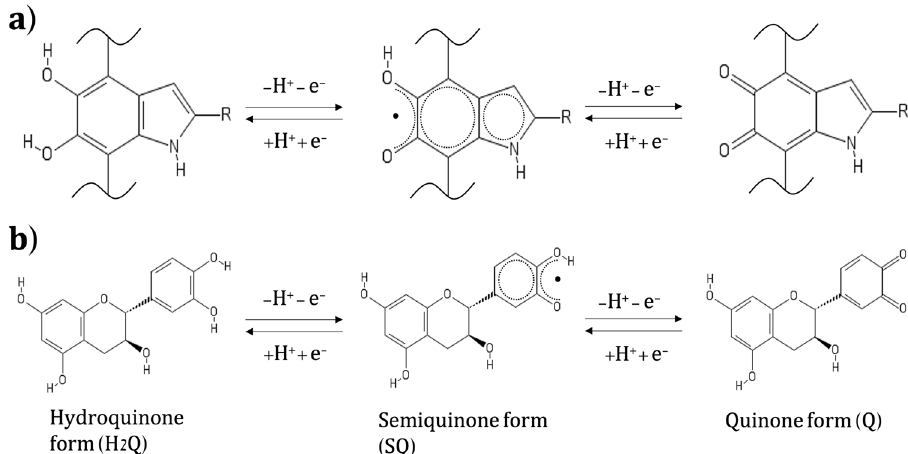
Fig. 1 Schematic representation of quinone redox forms. a Redox forms of the building blocks of eumelanin: 5,6-dihydroxyindole (DHI) and 5,6 dihydroxyindole-2-carboxylic acid (DHICA). R is − H in DHI and − COOH in DHICA. b Redox forms from catechol to catequinone for catechin